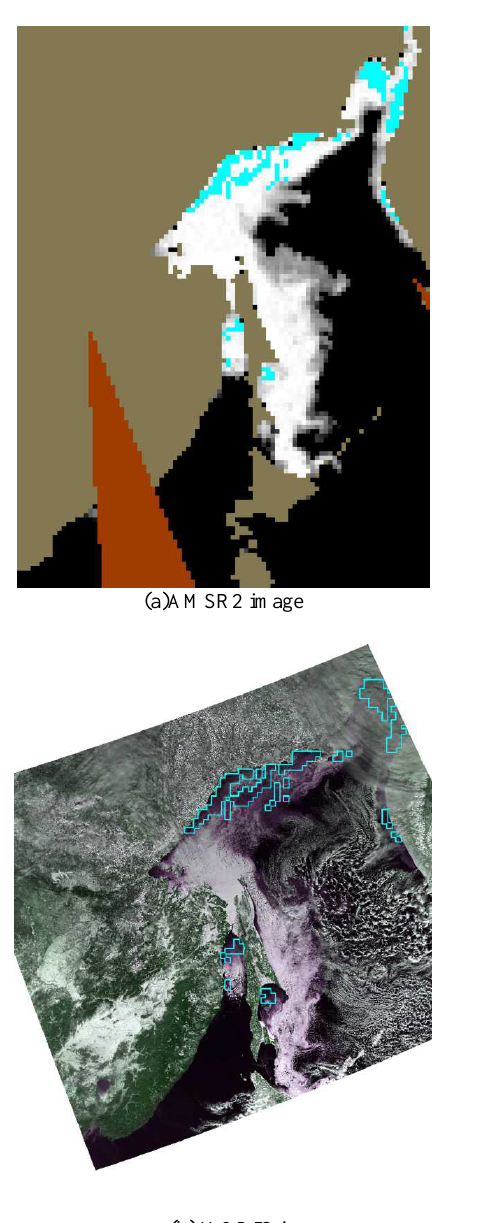
Figure 12. Scatter plots of (19GHzV – 19GHzH) Vs 19G H polarization (Sea of Okhotsk, March 11, 2014)